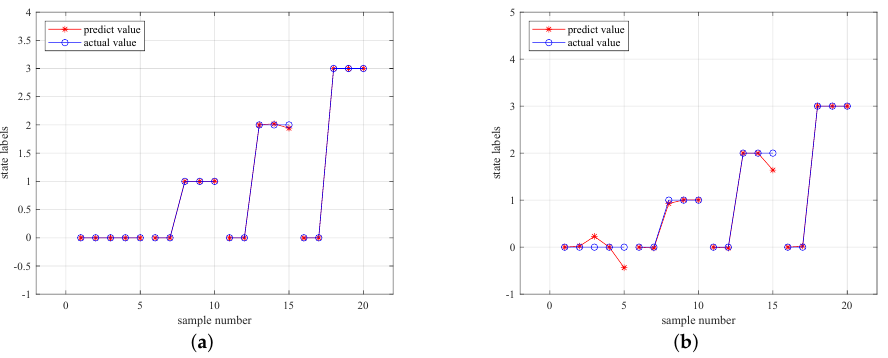
Figure 9. ( a ) Results of fault diagnosis using the method proposed; ( b ) results of fault diagnosis using the contrast method.